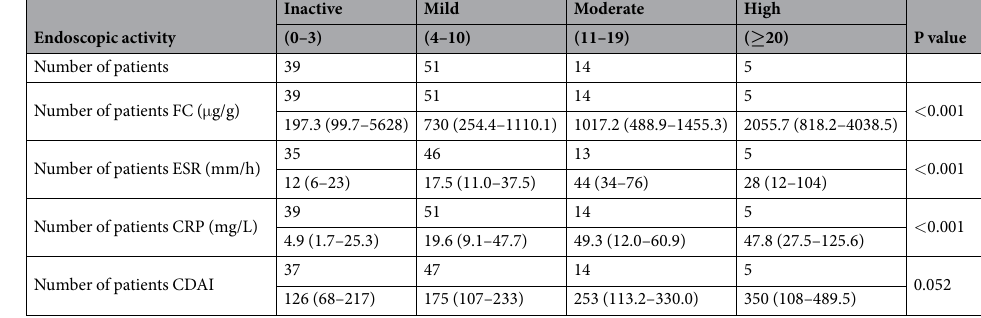
Table 3. Levels of FC, ESR, CRP and CDAI, sub-grouped according to SES-CD. Median interquartile range (IQR) for continuous variables; SES-CD, simple endoscopic score for Crohn’s disease; FC, faecal calprotectin;